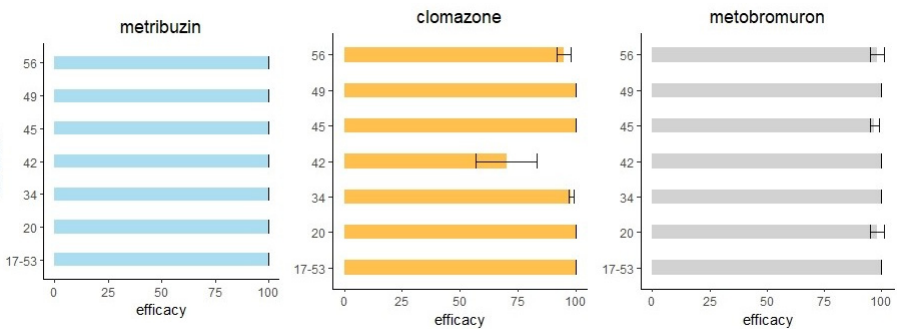
Figure 4. Mean values and standard errors are reported of metribuzin, clomazone and metobromuron efficacy, applied in pre-emergence. Accession 17–53 is the susceptible check.